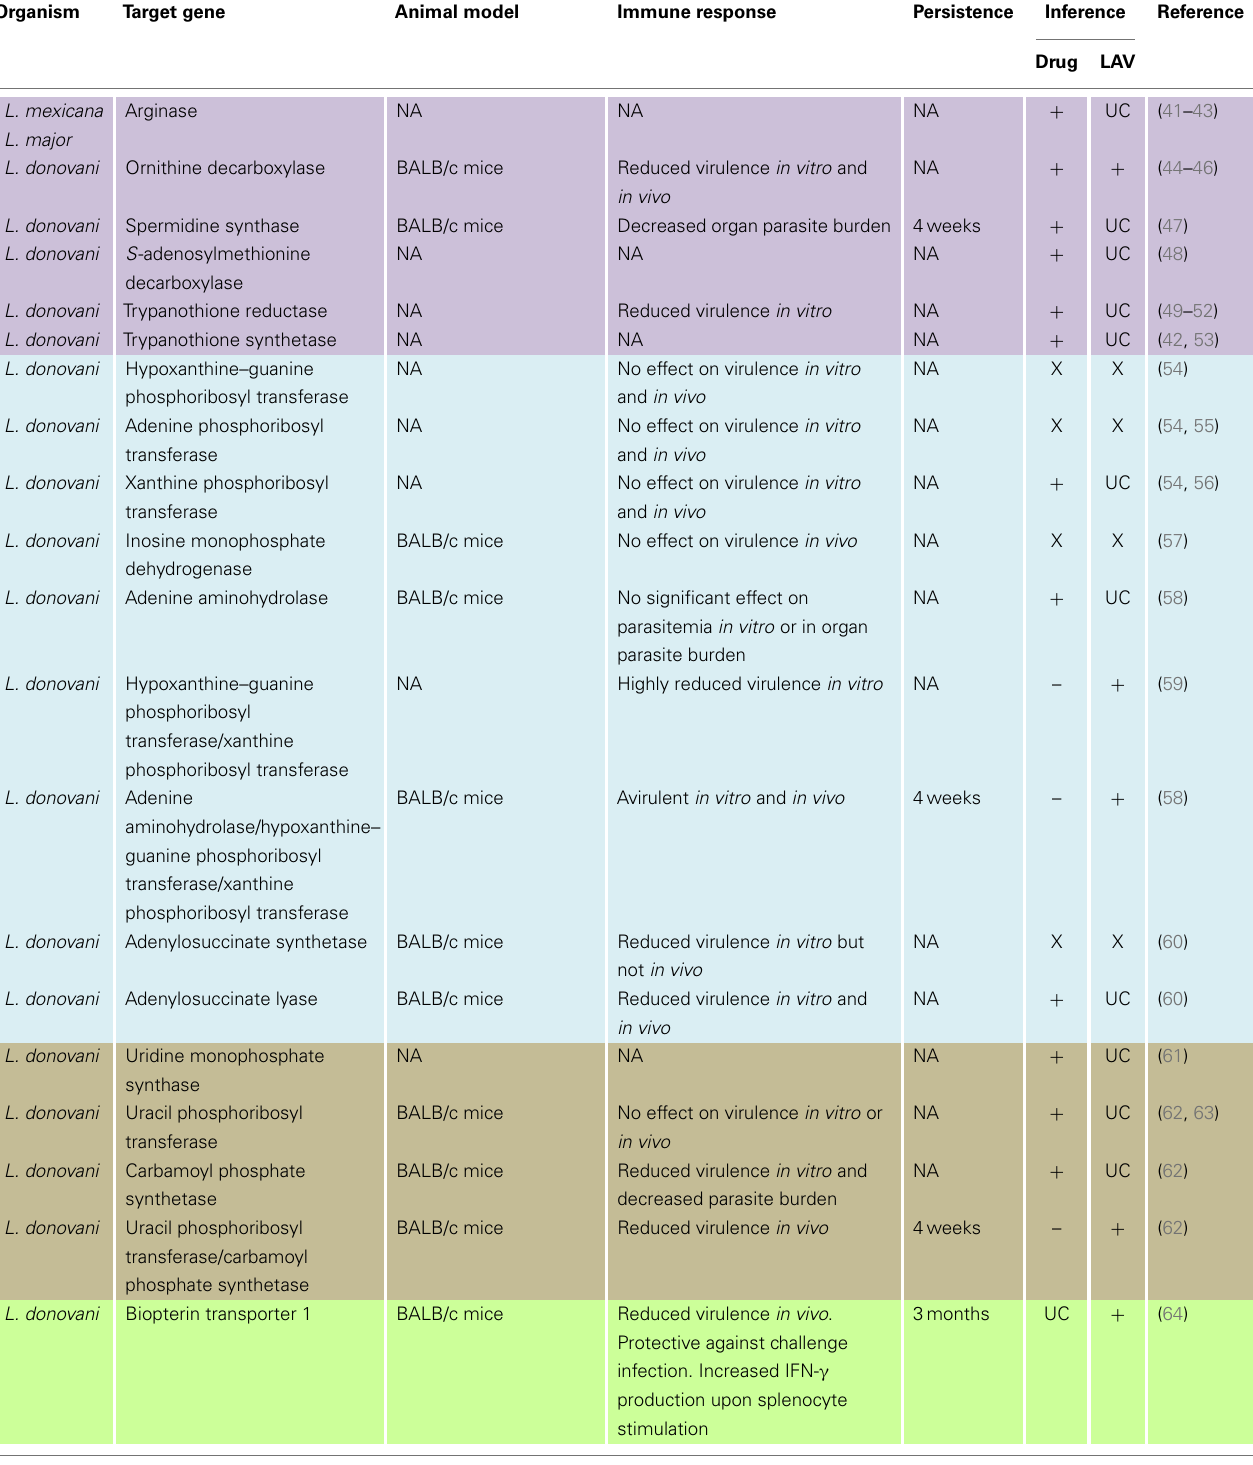
Table 1 | Genetic deletions that led to the discovery of novel drug or vaccine candidates inVL causing organisms .